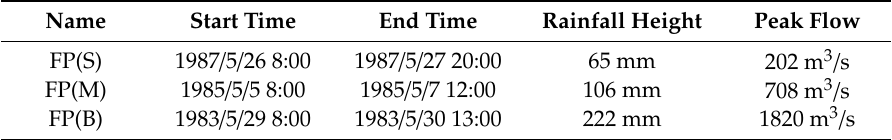
Table 2. The three typical flood processes